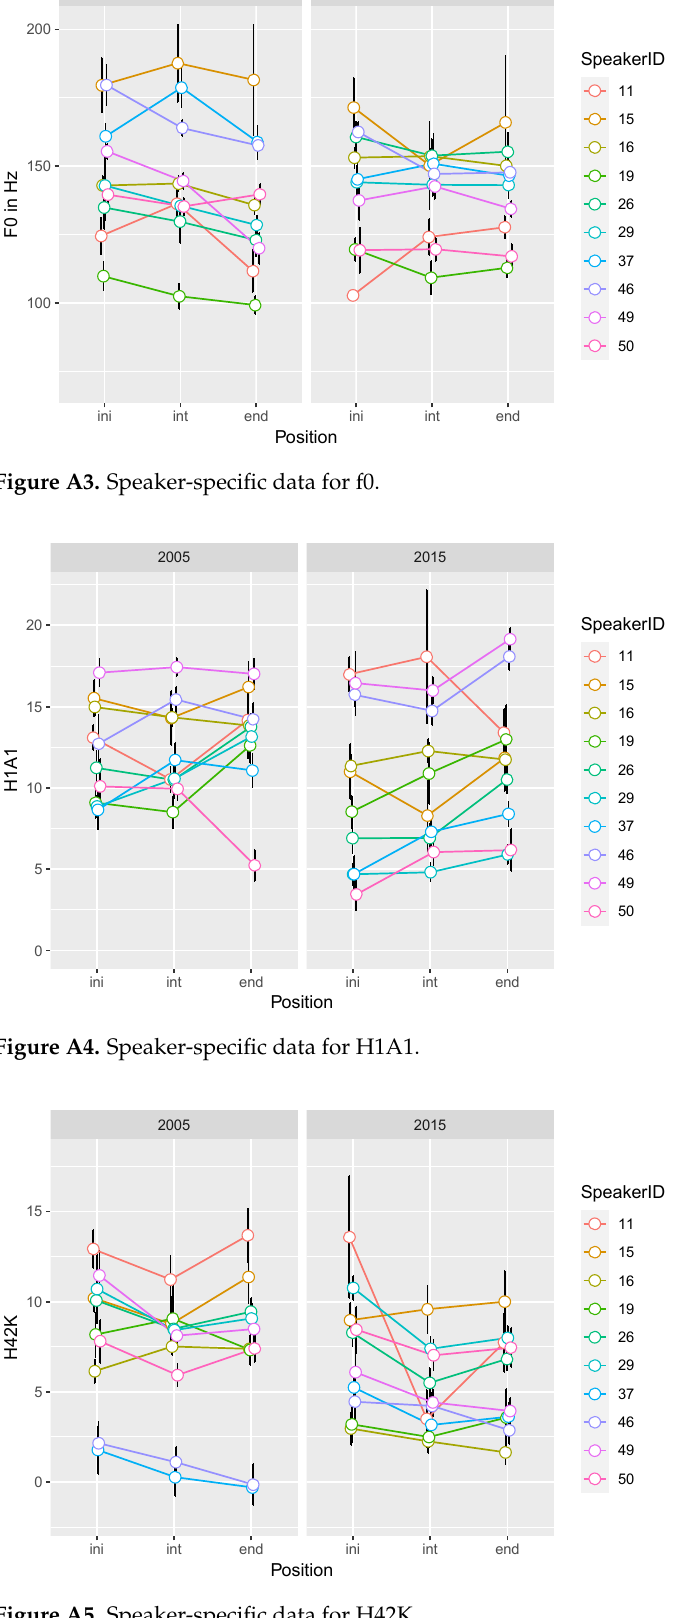
Figure A5. Speaker-specific data for H42K .